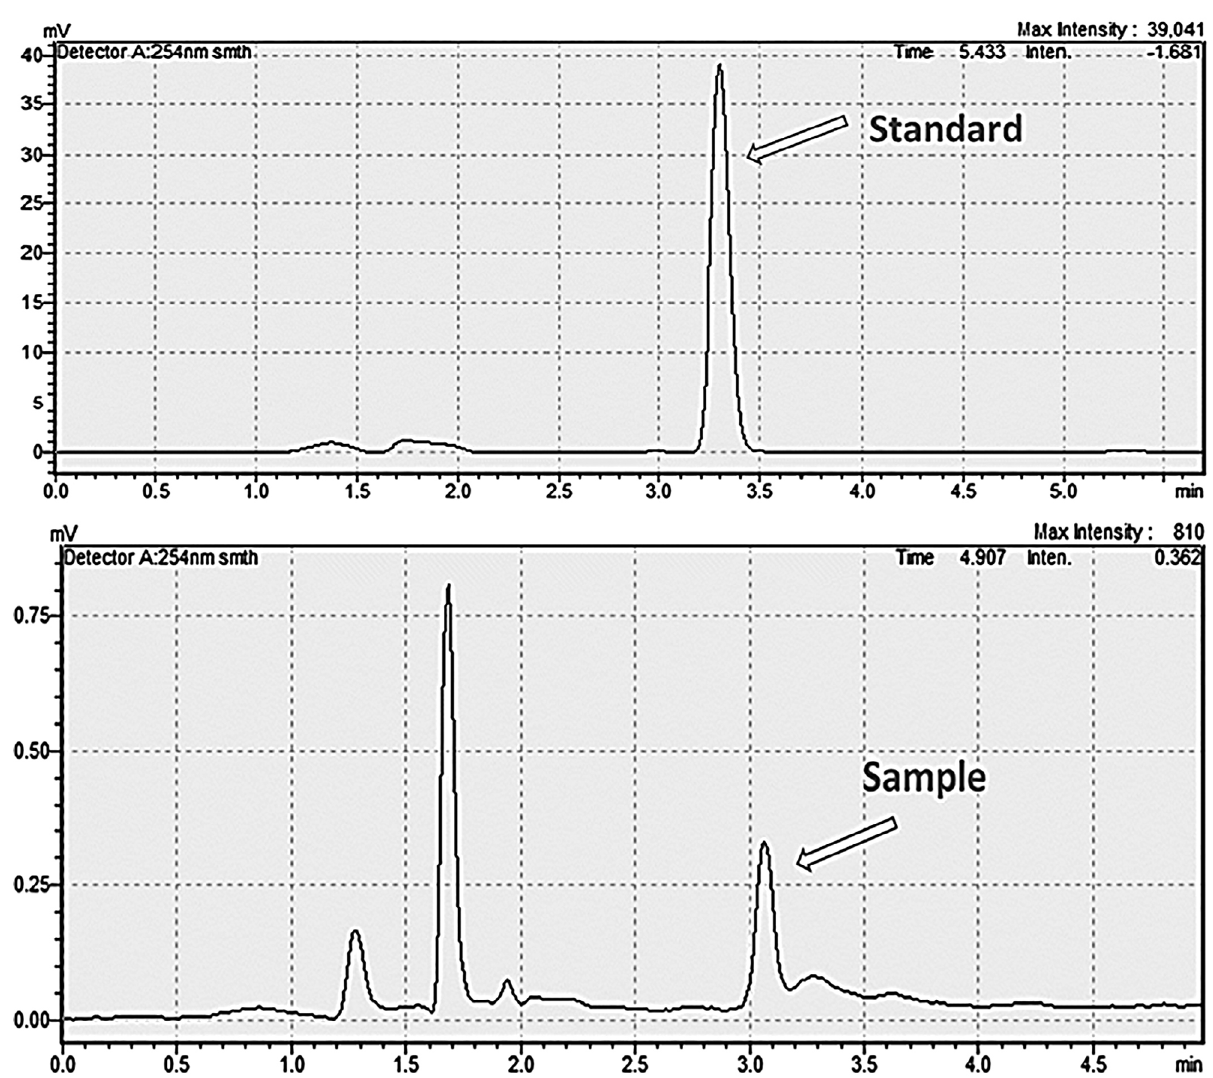
Figure 3- Representative chromatograms of reference MMA (top) and of a specimen elution (bottom)